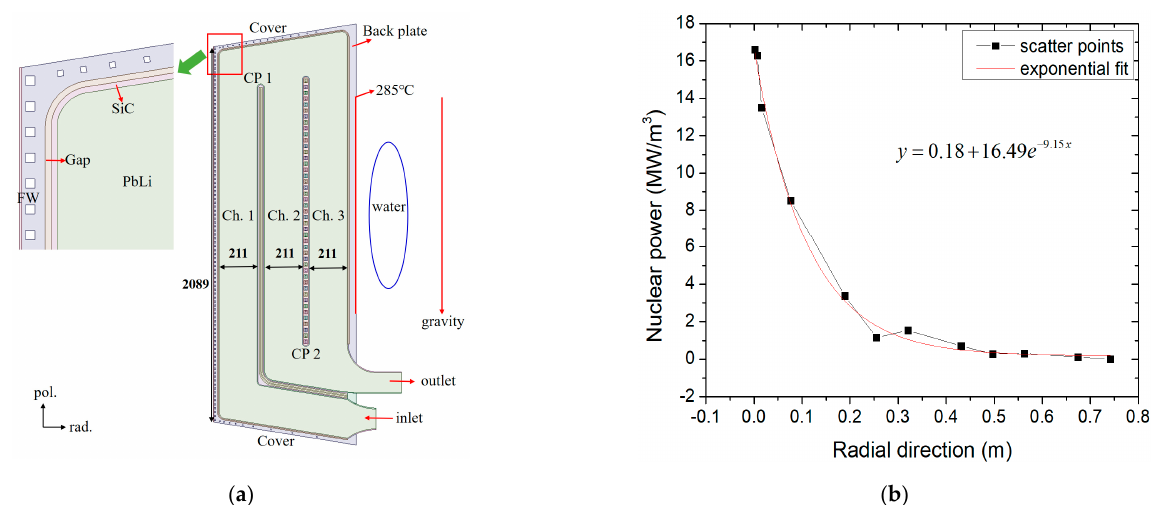
Figure 3. ( a ) Two dimensional numerical model; ( b ) radial power distribution. Table 2. Boundary conditions for numerical analysis [20,21].